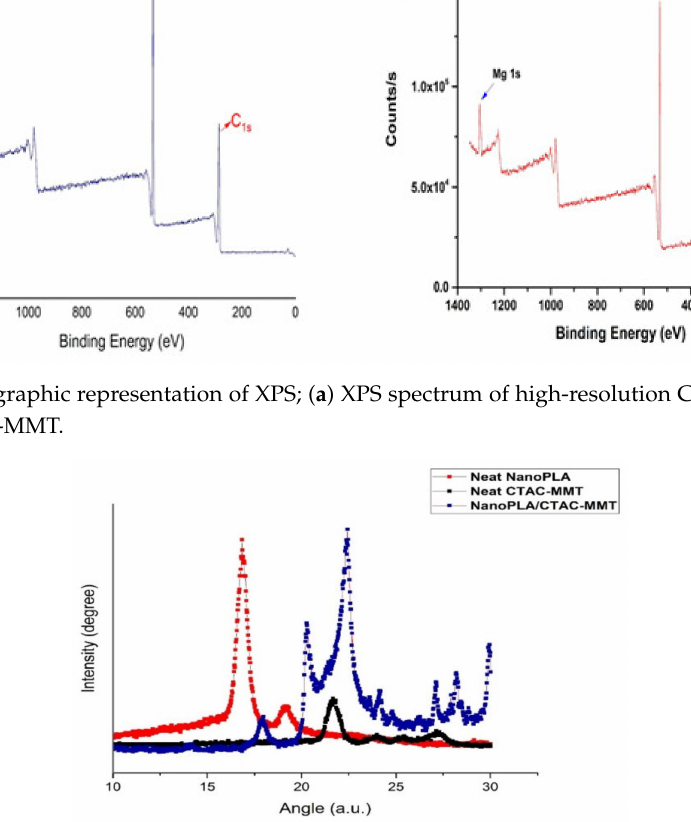
Figure 9. XRD patterns of Neat PLA (Black), Neat CTAC-MMT and PLA / CTAC-MMT